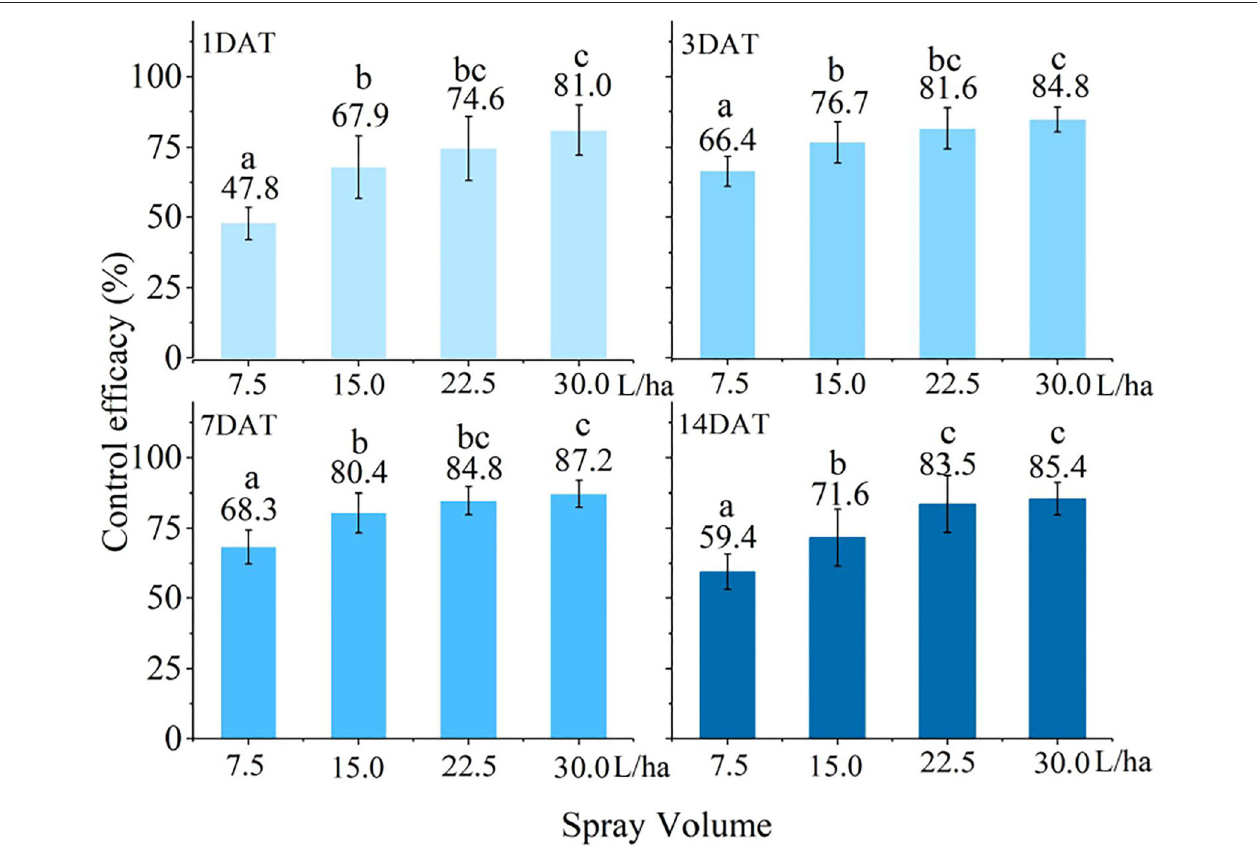
FIGURE 7 | Control efficacy (%) of fall armyworm (FAW) was evaluated at 1, 3, 7, and 14 days after treatment (DAT) resulting from field-treated 25% Spinetoram water-dispersible granule (Delegate ® ) with an unmanned aerial spray system sprayer at four spray volumes (the different lowercase letters indicate significant results, p <